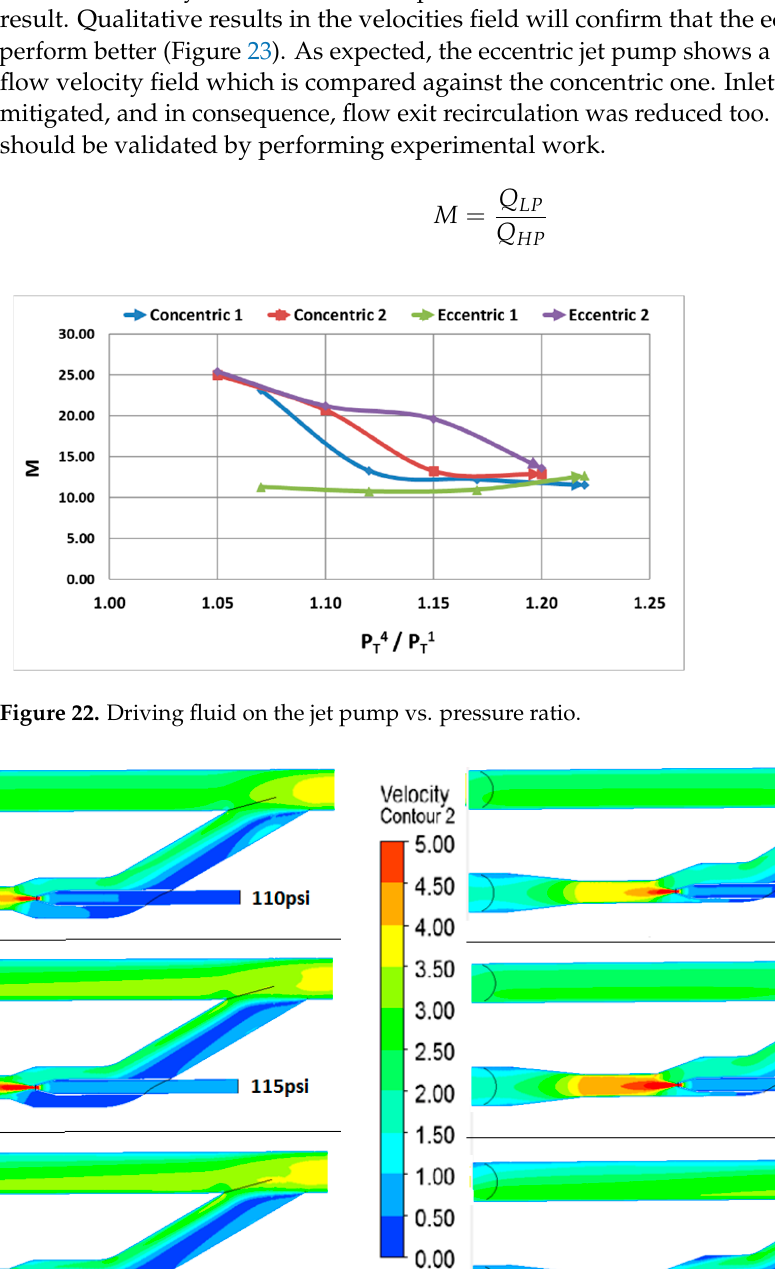
Figure 21. ( a , b ) Single-phase Eccentric Jet pump vs. Concentric Jet pump Case of study Quifa Field.